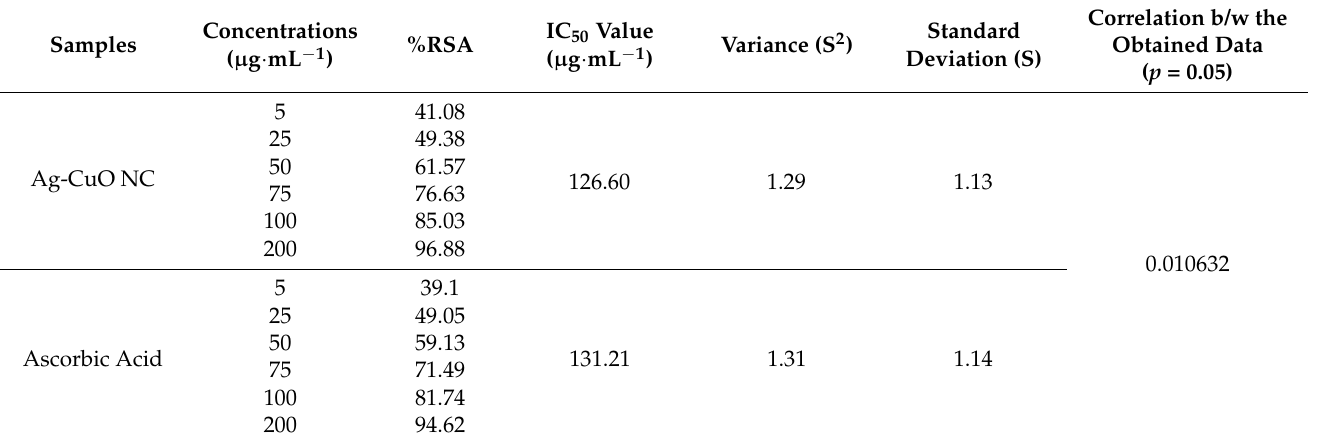
Table 2. Antioxidant activity of Ag-CuO NC against ABTS free radicals at different concentrations.